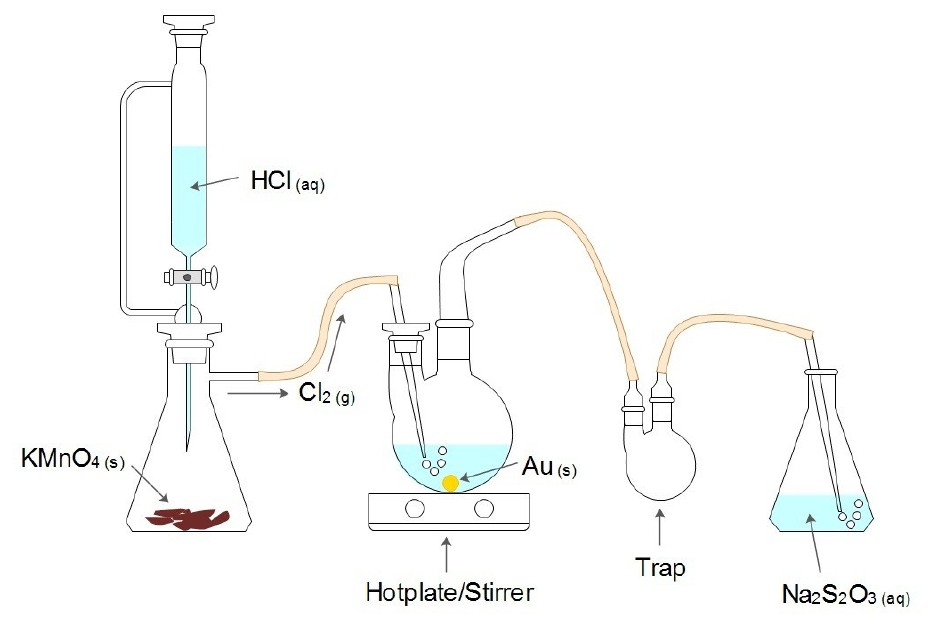
Figure 1. Apparatus for the synthesis of aqueous tetrachloroauric